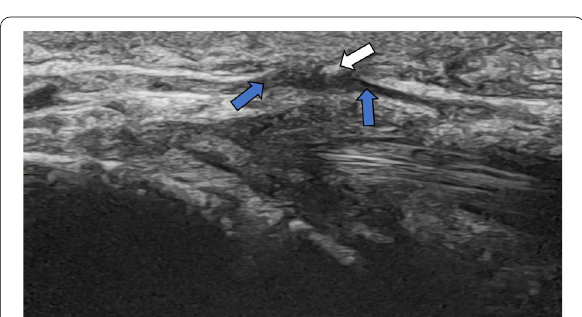
Fig. 17 Ultrasound thumb in patient with right thumb pain post trigger finger release. There is fusiform enlargement of the digital nerve (blue arrows) palmar-radial to the site of the prior A1 pulley release, extending over a length of 5 mm. Sonographic palpation elicited the usual symptom of pain radiating down the thumb. There is an echogenic focus (white arrow) immediately superficial to the nerve which may represent suture material (or calcification). This is consistent with entrapment given the proximity to the site of prior